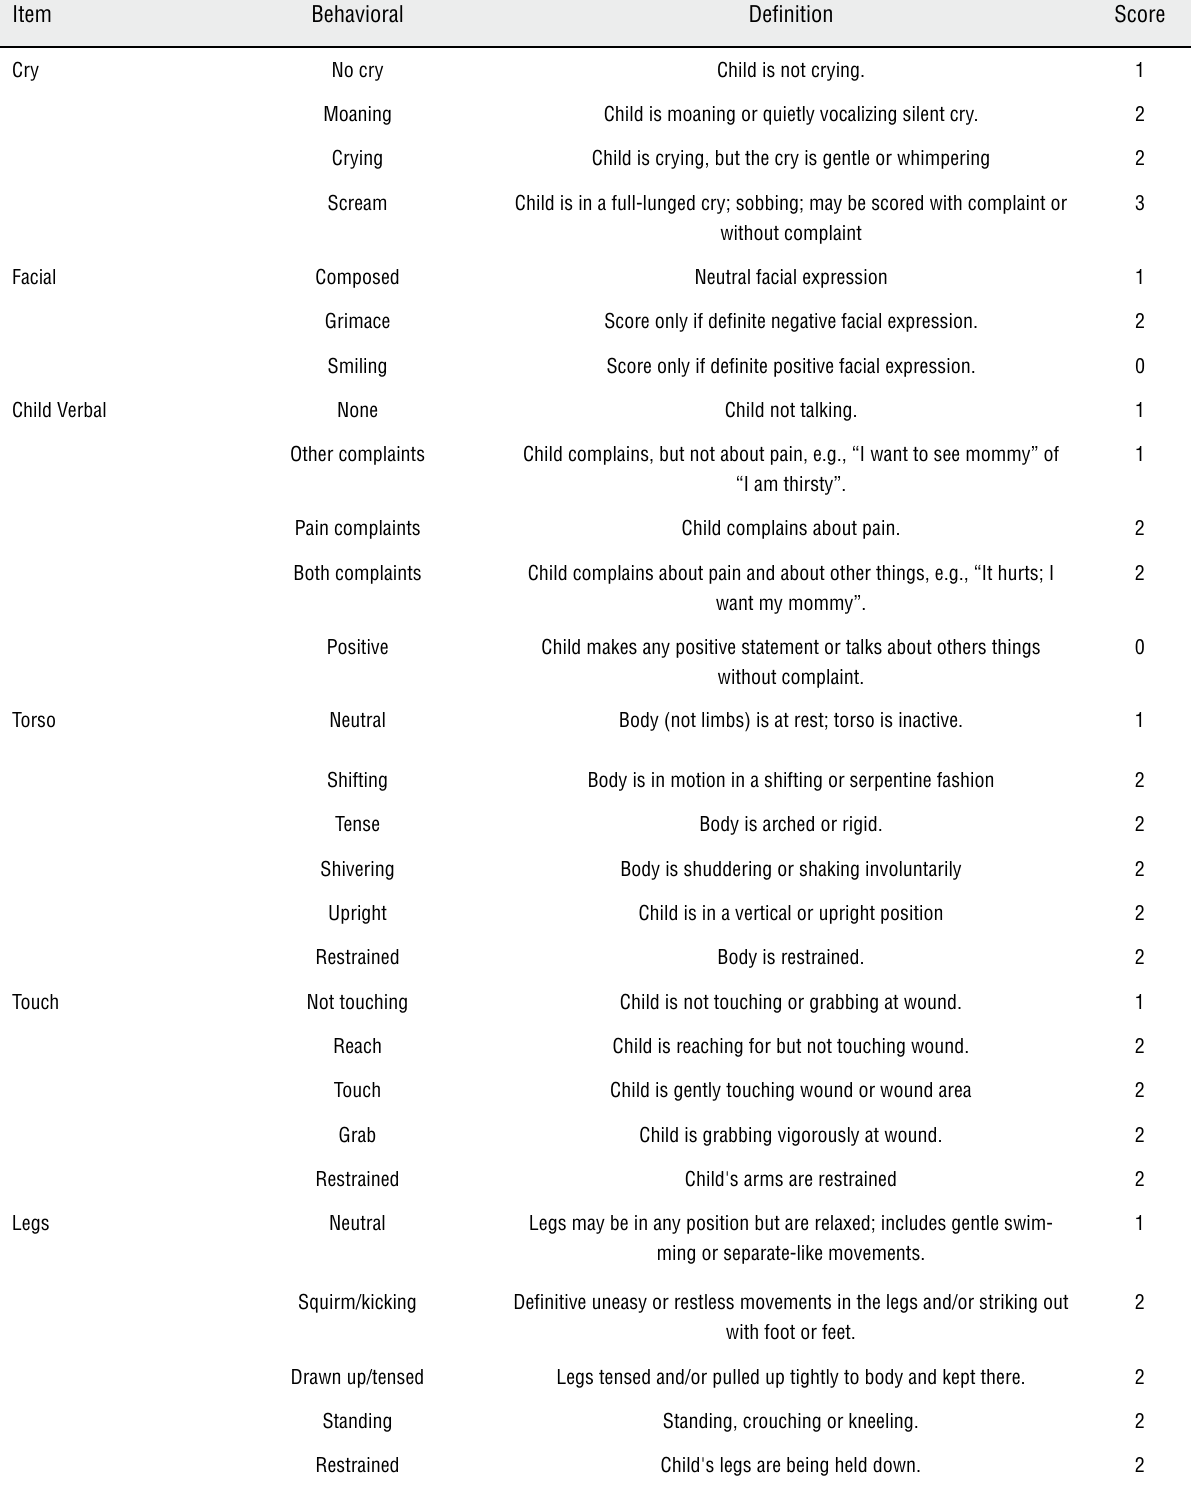
Table 1 - Children's hospital Eastern Ontario Pain Scale